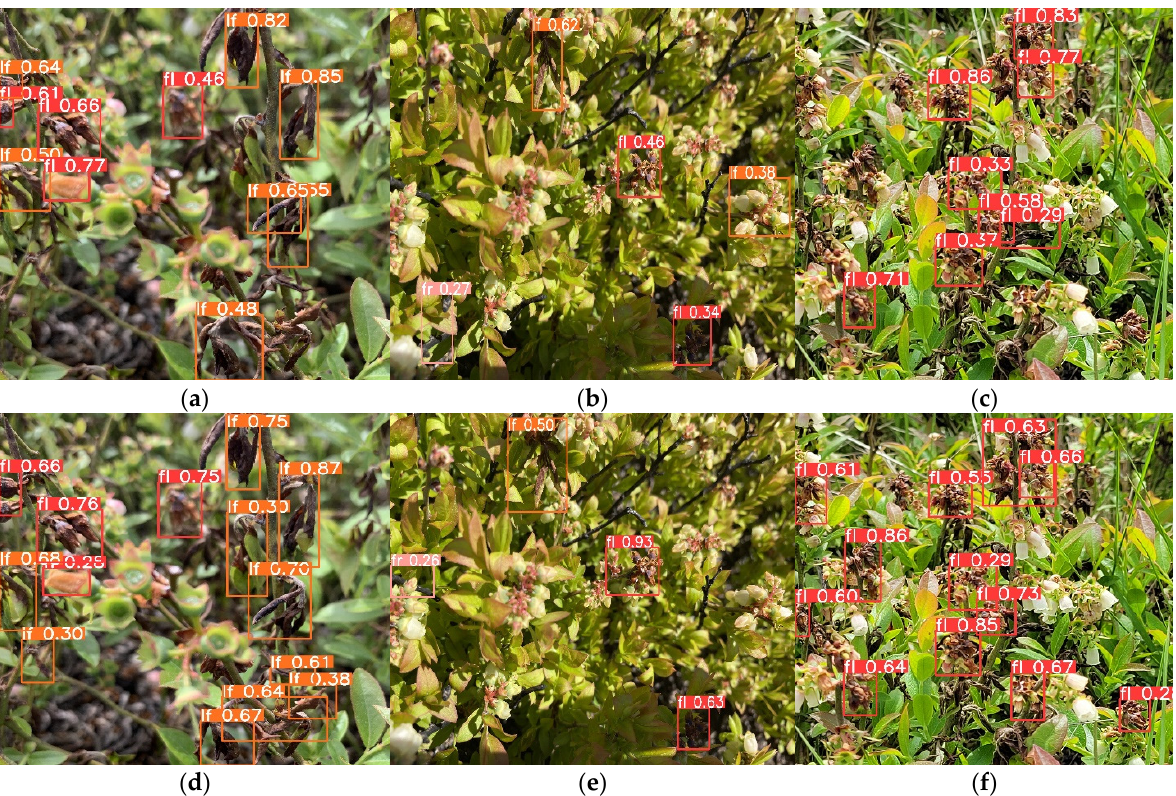
Figure 9. Comparison of detection results focused on the clone. Yolov5s ( a – c ) and Yolov5s-CA ( d – f ).